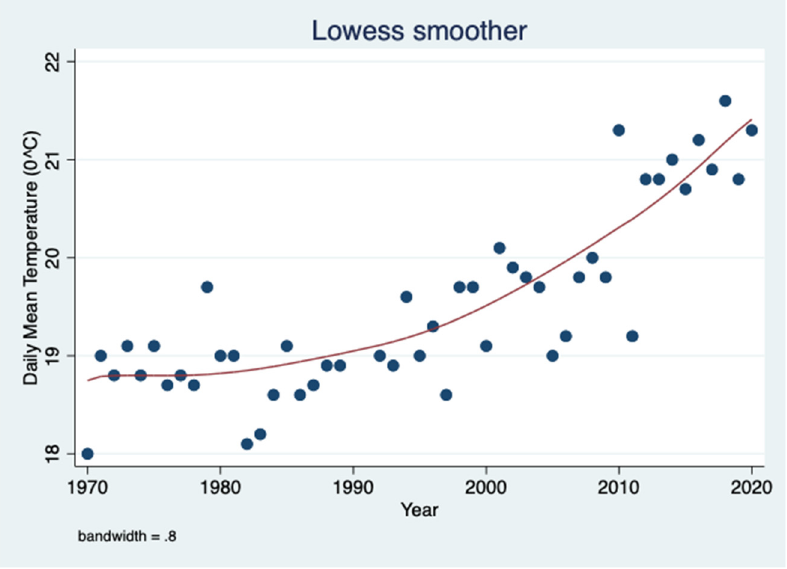
Figure 3. Temporal changes in climate conditions in the Kinneret watershed. Annual means of daily mean temperature (Dafna Station). LOWESS Smoother (0.8 bandwidth) during 1970–2020.